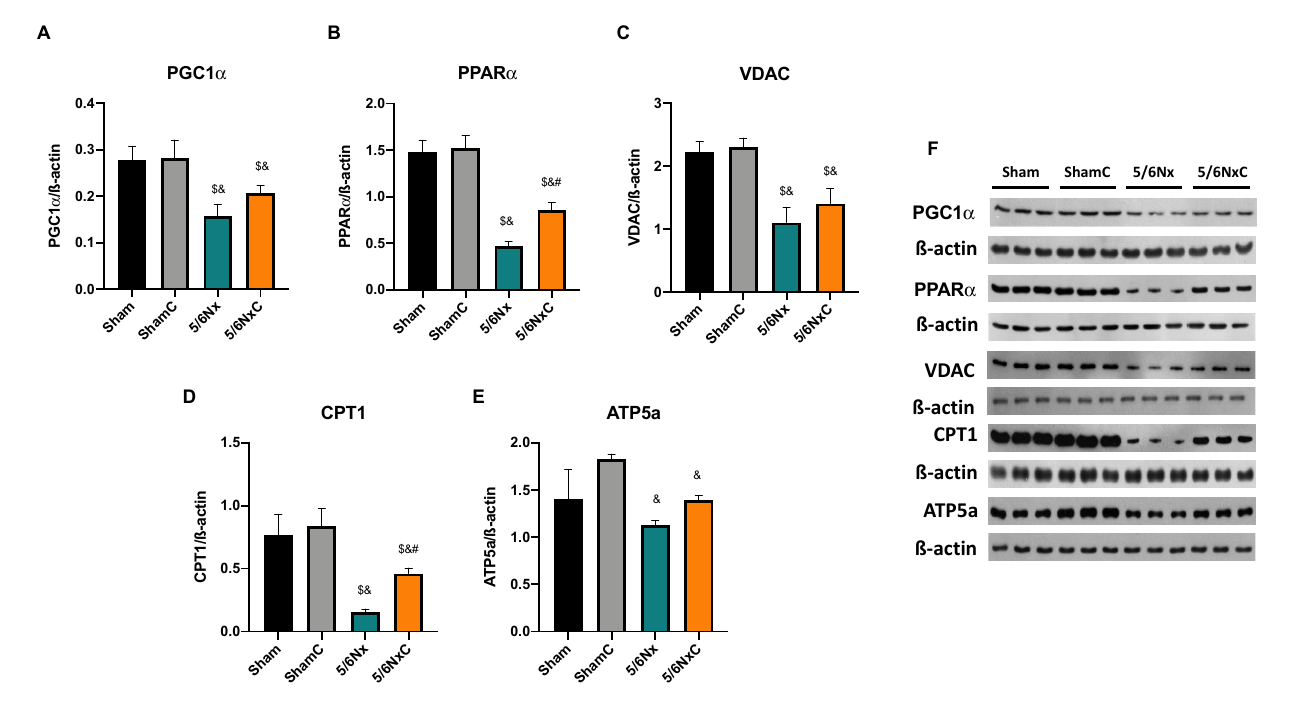
Figure 6. Kidney mitochondrial biogenesis and β -oxidation related proteins abundance in the four groups of rats studied: Sham, Sham + curcumin (ShamC), five-sixths nephrectomy (5/6Nx), and 5/6Nx + curcumin (5/6NxC). ( A ) Peroxisome proliferator-activated receptor γ co-activator 1 α (PGC1 α ), ( B ) Peroxisome proliferator-activated receptor alpha (PPAR α ), ( C ) Voltage-dependent anion channel (VDAC), ( D ) Carnitine palmitoyl transferase (CPT1), ( E ) ATP synthase 5a (ATP5a) and ( F ) representative images of western blot. β -actin was used as a loading control. One-way analysis of variance (ANOVA), post hoc Fisher´s Least significant difference (LSD), Mean ± SD, n = 3. $ p < 0.05 vs. Sham, & p < 0.05 vs. ShamC, # p < 0.05 vs 5/6Nx.